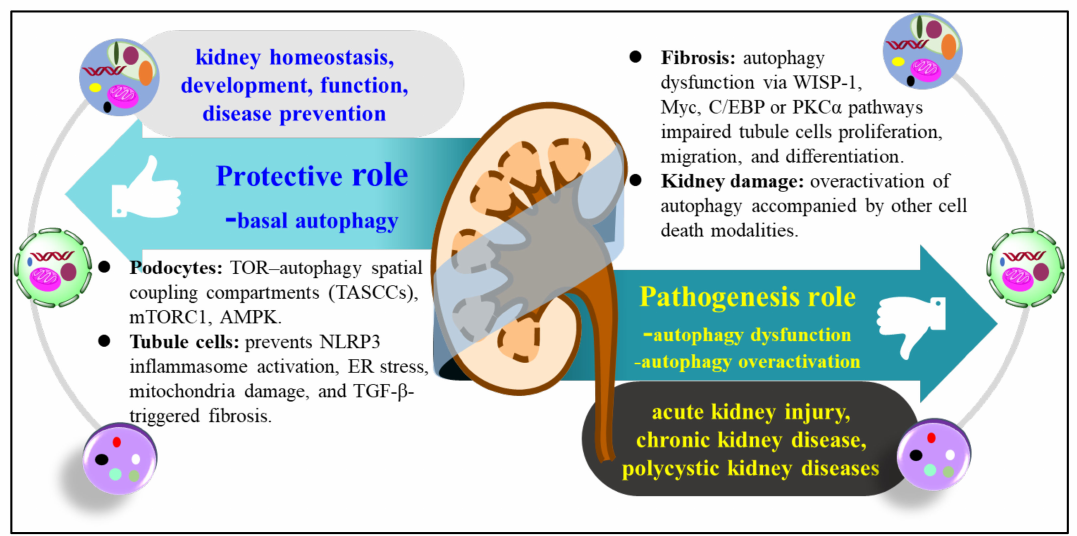
Figure 2. The dual role of autophagy in kidney homeostasis and disease. Basal autophagy is a protective role in the maintenance of kidney homeostasis, structure, and functions. TOR–autophagy spatial coupling compartments (TASCCs), mTORC1 and AMPK are major pathways contributed to the maintenance of podocyte homeostasis. In tubular cells, autophagy prevents inflammation and fibrosis via downregulating NOD-like receptor (NLR) family pyrin domain containing 3 (NLRP3) inflammasome activation and ER stress. However, pathogenesis role of autophagy contributes to acute kidney injury, chronic kidney diseases and polycystic kidney diseases via WNT family member 1 (WNT1)-induced signaling pathway protein-1 (WISP-1), Myc, CCAAT-enhancer-binding protein (C/EBP) or protein kinase C alpha (PKC α ). Meanwhile, autophagy dysfunction or over activation accompanied by other cell death modalities might induce tubular atrophy, promote kidney fibrosis, thereby, aggravate kidney